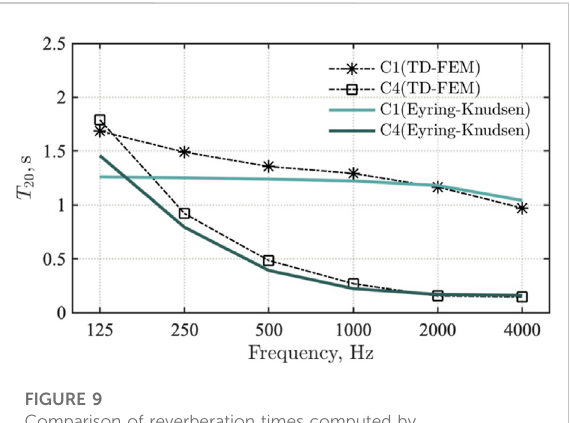
FIGURE 9 Comparison of reverberation times computed by Eyring – Knudsen formula and TD-FEM for cases C1 and